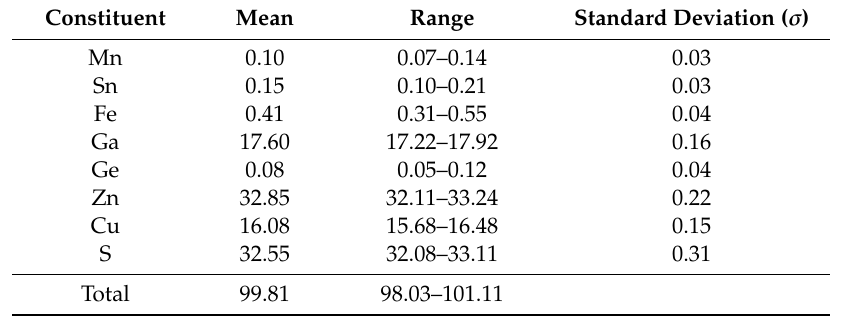
formula unit, is: The simplified formula is